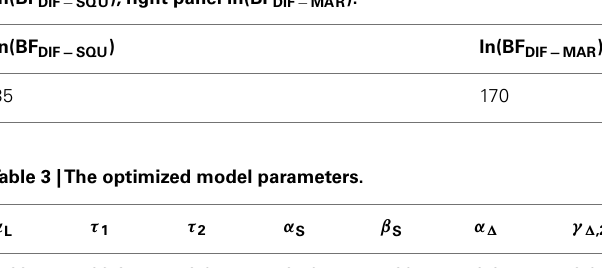
Table 2 |The maximum log-Bayes factors ln(BF DIF − XXX ), left panel